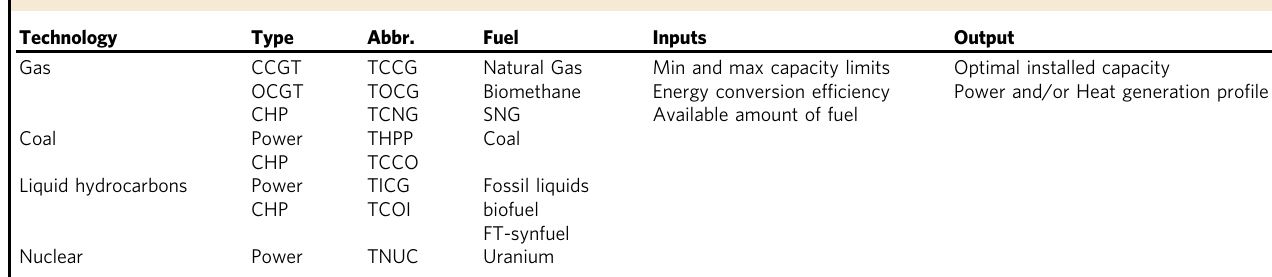
Table 4 Fossil-fuel-based power generation